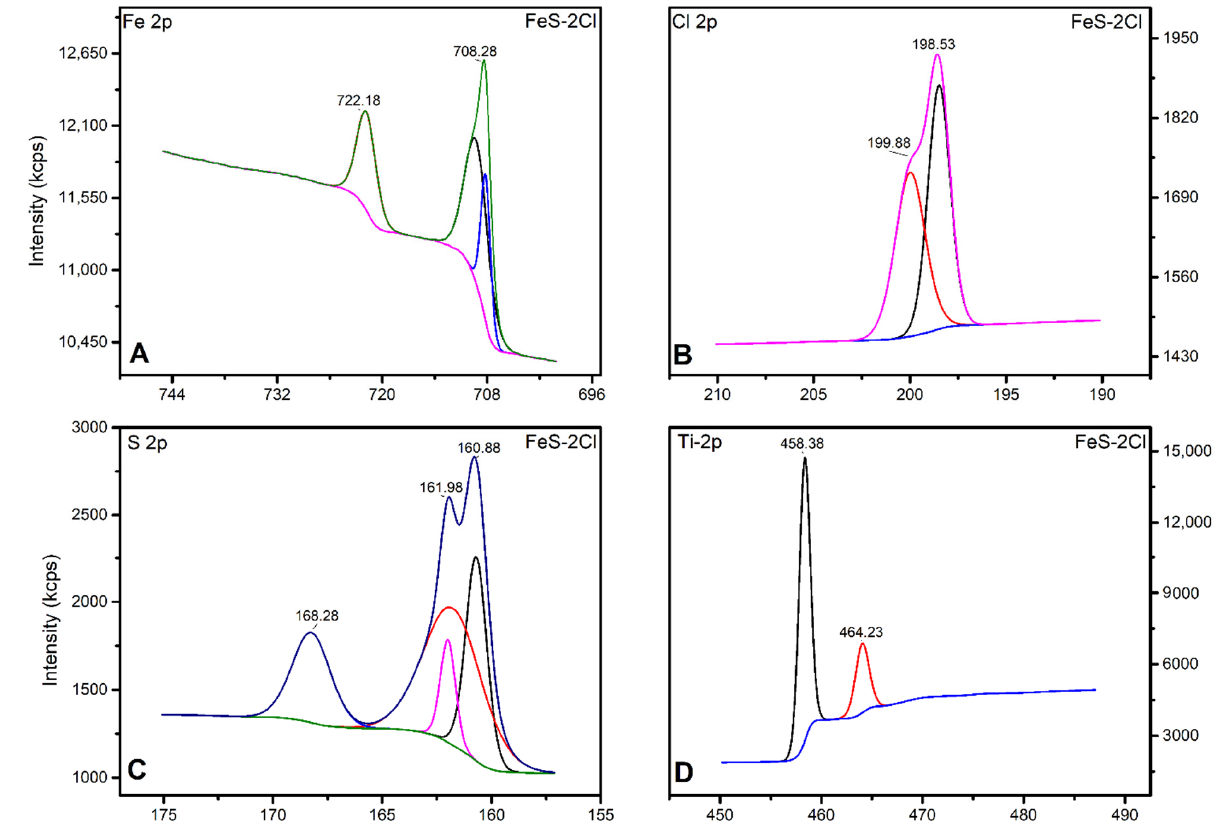
Figure 10. XPS spectrum for catalyst FeS–2Cl. ( A ) Fe 2p, ( B ) Cl 2p, ( C ) S 2p and ( D ) Ti